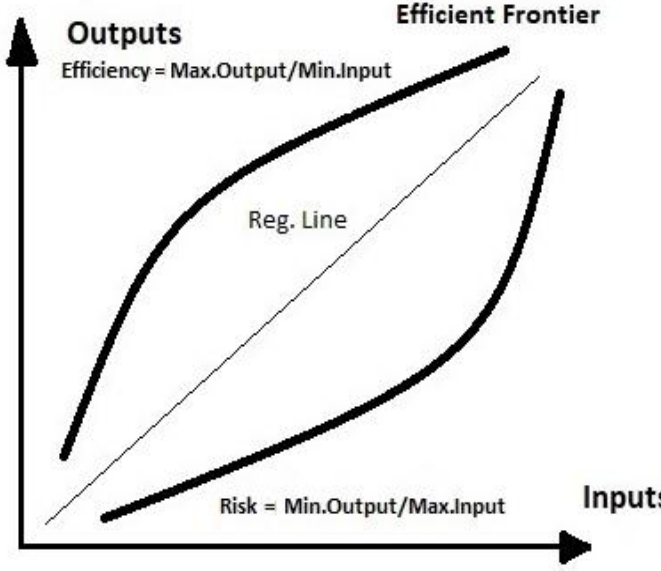
Figure 5. Basic DEA Model Conceptual Diagram [33].